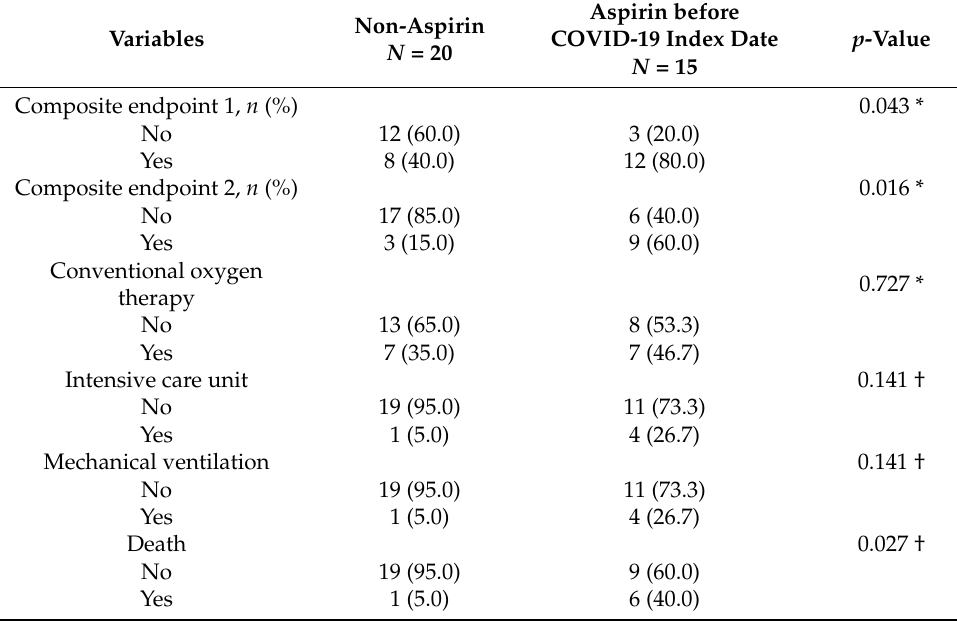
Table 4. Clinical outcomes of COVID-19 between non-aspirin and aspirin users before